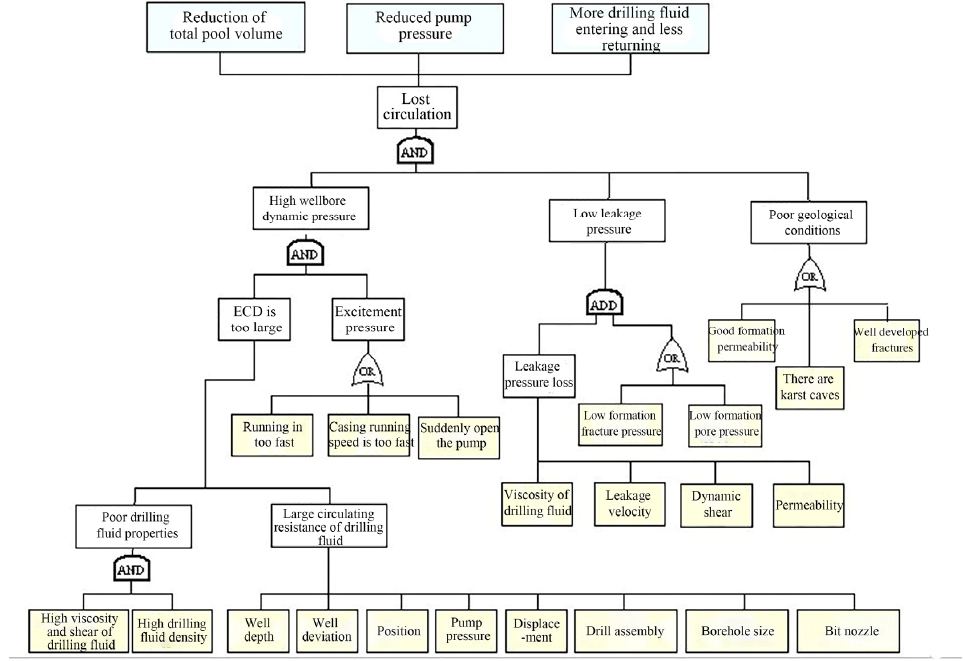
Figure 7. Lost circulation model.